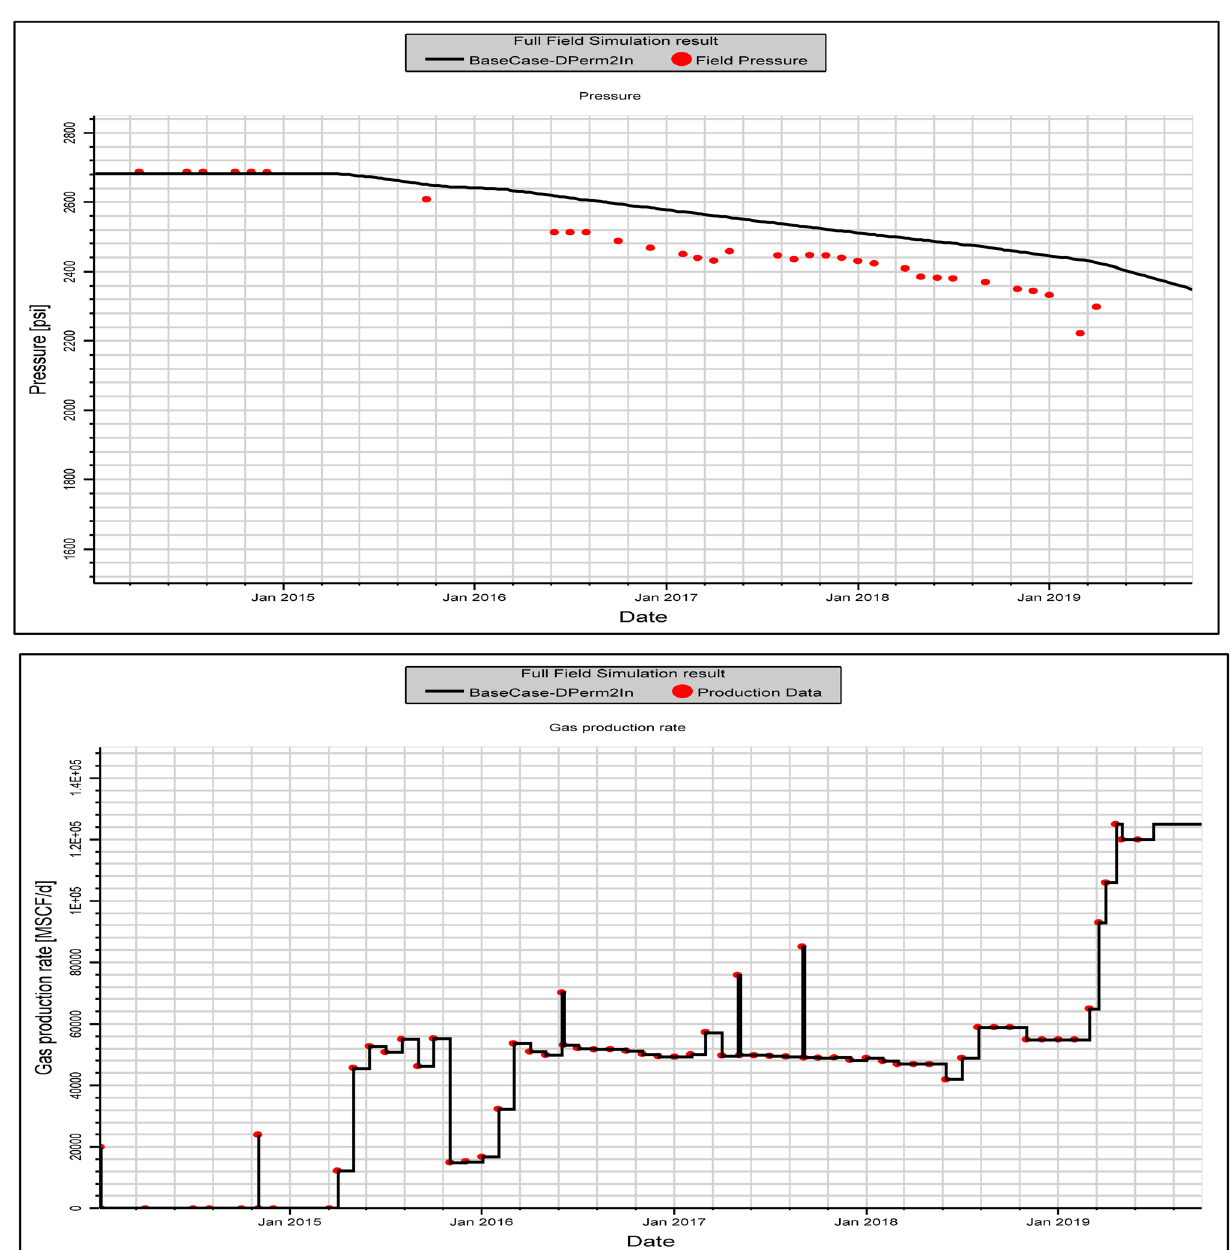
Fig. 14 Initial simulation